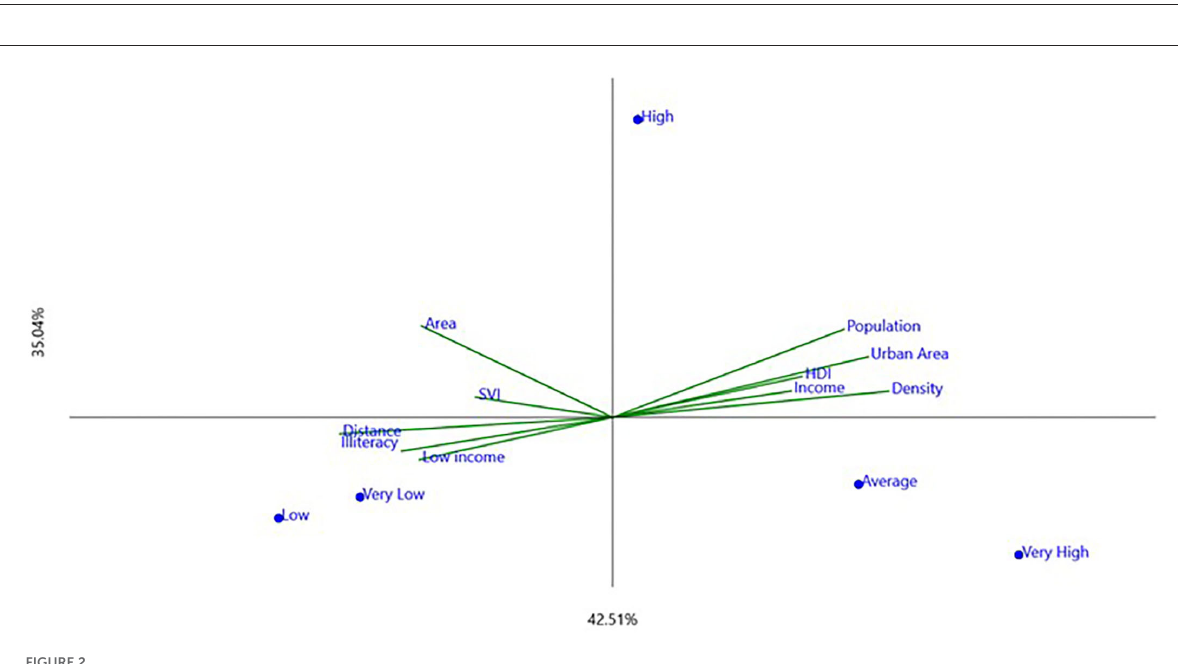
and quantitative variables, have been performed and presented (Figures 1,